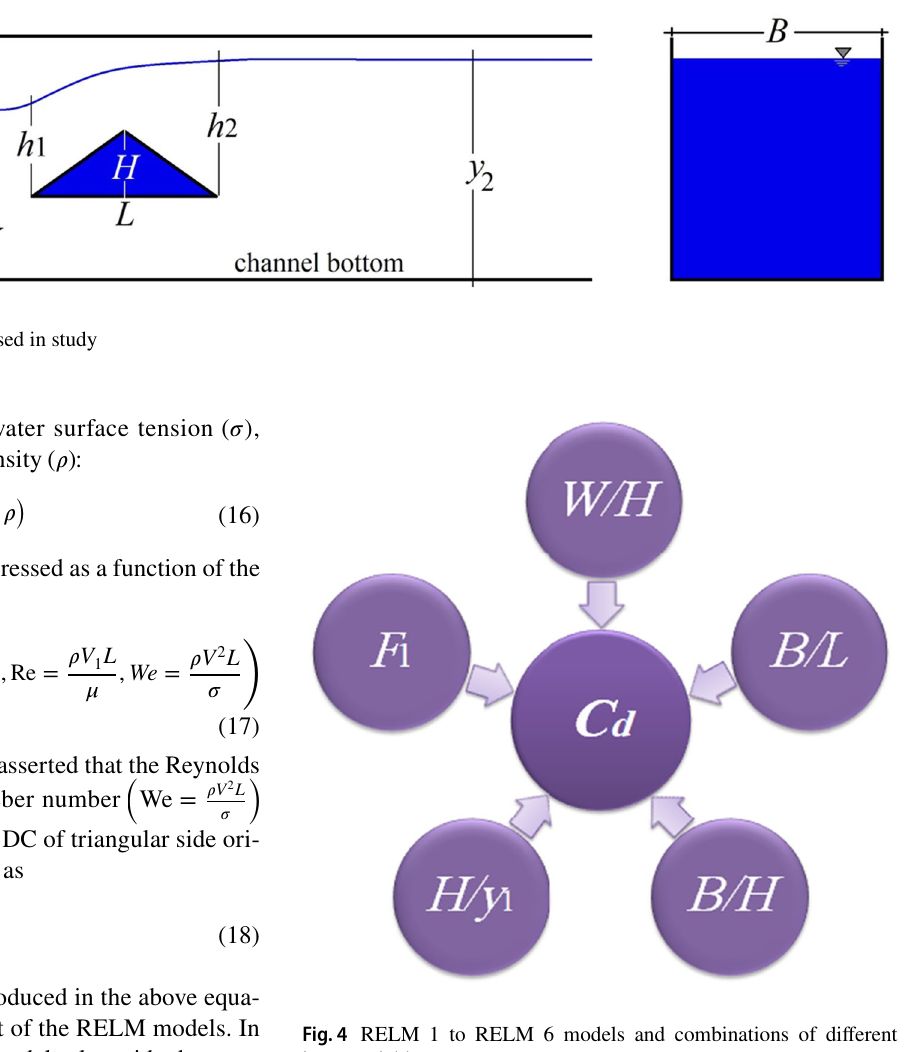
Fig. 4 RELM 1 to RELM 6 models and combinations of